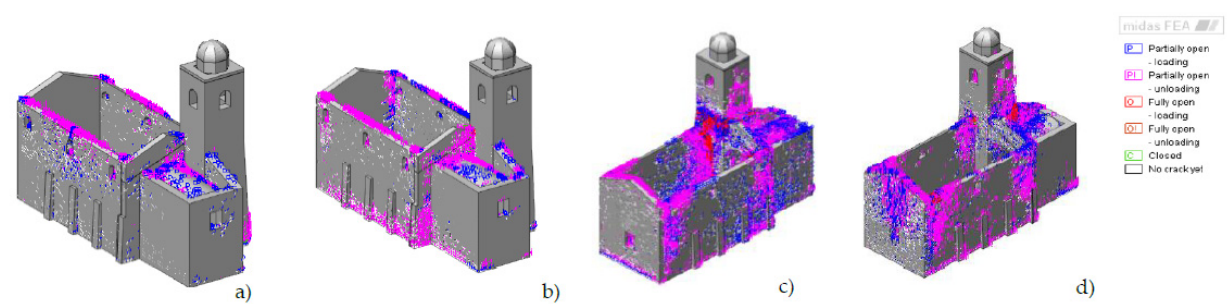
Figure 11. Numerical damage for San Francesco Church in Montefortino (Fermo, Central Italy) for PushMass + x ( a ), PushMass − x ( b ), PushMass + y ( c ), PushMass − y ( d ).